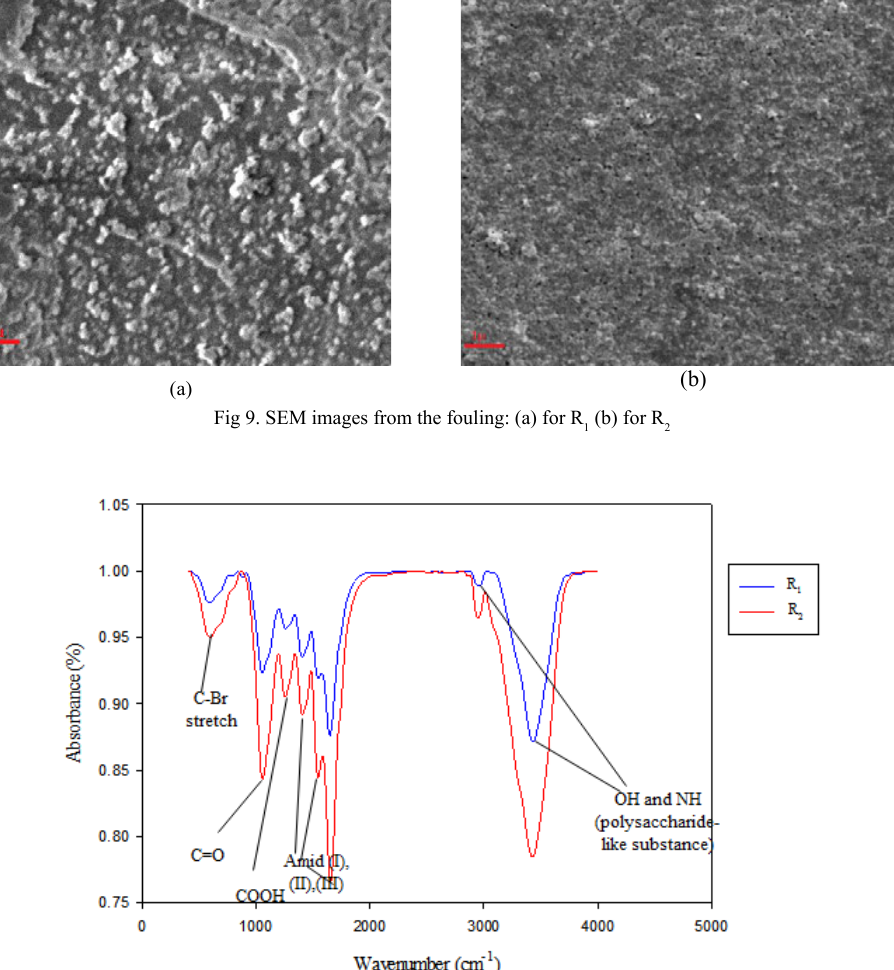
Fig. 10. The peaks obtained the FTIR analysis of the